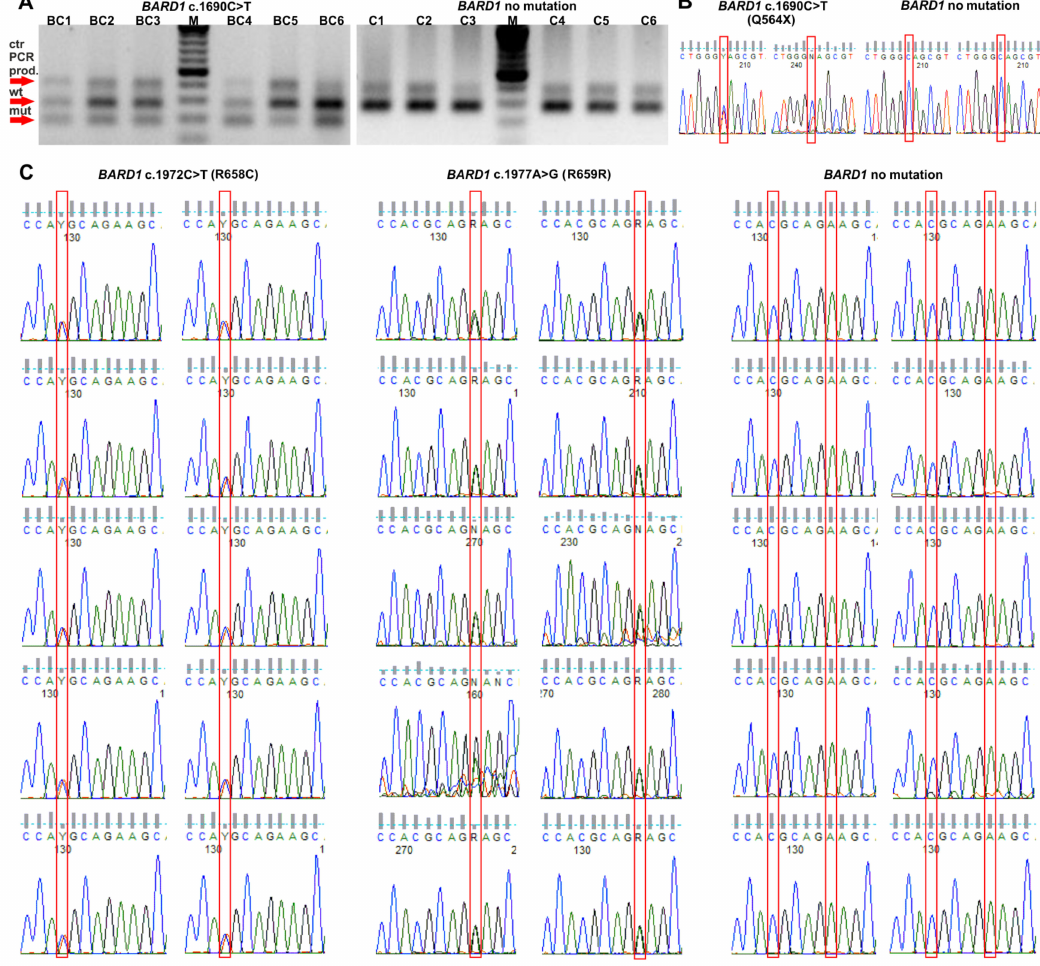
Figure 1. Validation of BARD1 variants. ( A ) Validation of p.Q564X BARD1 mutation in randomly selected carriers and noncarriers with the tetra-primer ARMS-PCR assay [BC: breast cancer patients; C: controls; M: marker, GeneRuler 100 bp Plus DNA Ladder (Thermo Fisher Scientific, Waltham, MA, USA)] and ( B ) with Sanger sequencing. ( C ) Validation of p.R658C and p.R659R BARD1 variants